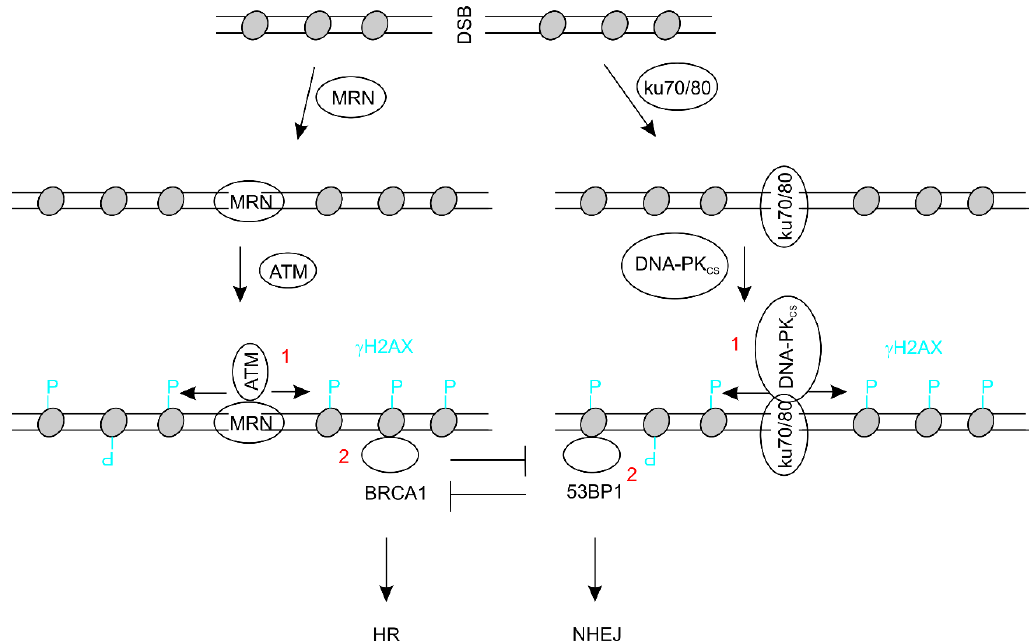
Figure 2. A model showing double strand break (DSB) repair pathways. For the homologous recombination (HR) and non ‐ homologous end joining (NHEJ) pathways, DSBs are first recognized by either the MRN or Ku70/80 complex, followed by the recruitment of ATM or DNA ‐ PK CS (the catalytic subunit of DNA ‐ PK) as indicated. ATM and DNA ‐ PK then phosphorylate H2AX at serine 139 to generate γ H2AX (event 1), which initiates event 2: recruiting either BRCA1 or 53BP1; recruitment of either inhibits the recruitment of another. 53BP1: p53 ‐ binding protein 1; ATM: ataxia ‐ telangiectasia mutated; BRCA1: breast cancer type 1 susceptibility protein; DSB: double strand DNA break; DNA ‐ PK: DNA ‐ dependent protein kinase; HR: homologous recombination; MRN: the complex of MRE11 ‐ NBS1 ‐ RAD50; NHEJ: non ‐ homologous end joining.